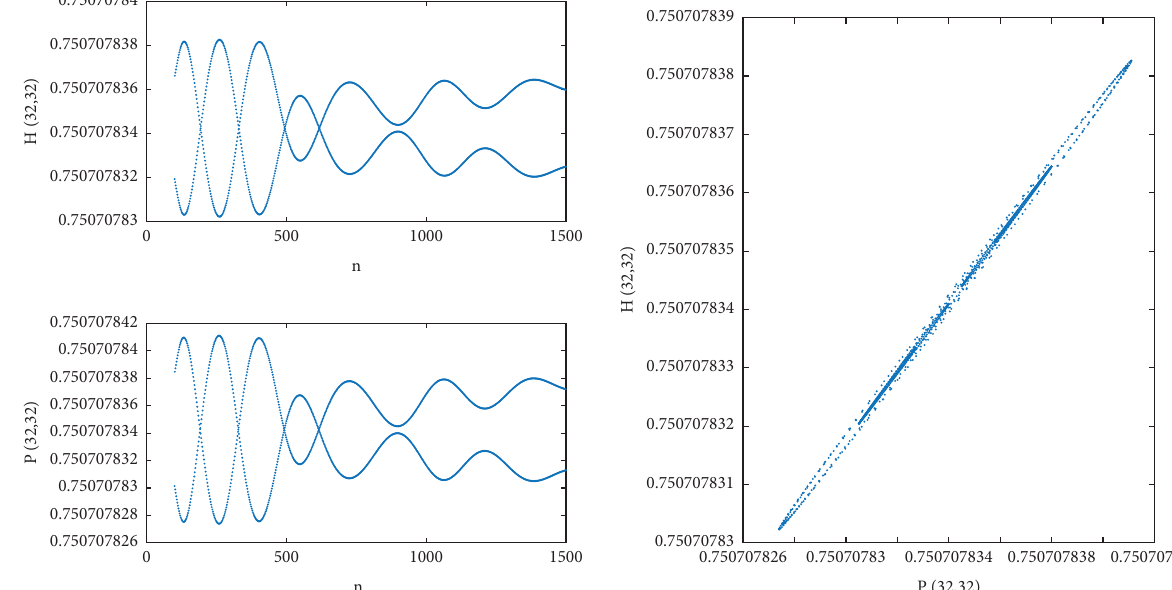
Figure 19: R � 2 , k � 1, c � 0 . 8, σ ∗ � 0 . 278655, σ � 0 . 5, ( d which is consistent with the case of Corollary 3(5), a 1: 2 Resonance occurs, parasite and host populations exhibit unstable period-doubling